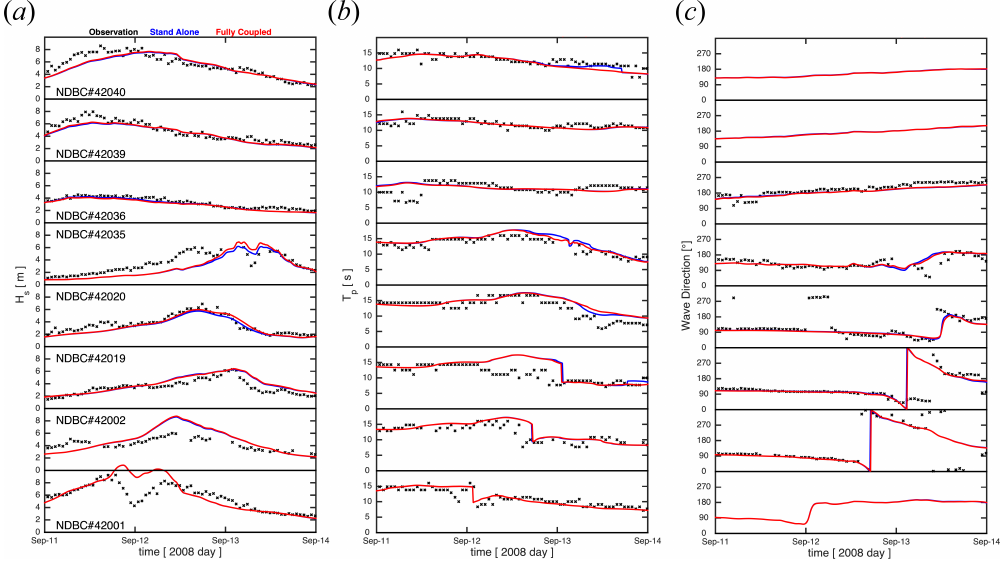
Figure 17. Model validation at the NDBC buoy locations, forced by the Hurricane Weather Research and Forecasting (HWRF) atmospheric model, extracted from Stand alone WW3 simulations (blue), Fully coupled wave-surge simulation (red) versus observation (black): ( a ) Significant wave height ( H s ); ( b ) peak period ( T p ) and ( c ) mean wave direction. All model configurations and results are pre-decisional and for official use